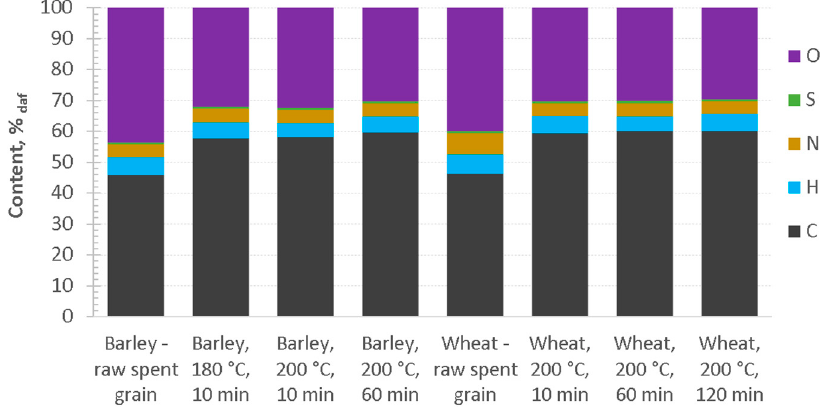
Figure 5. Molar ratios (O/C and H/C) for feedstocks and respective hydrochars.